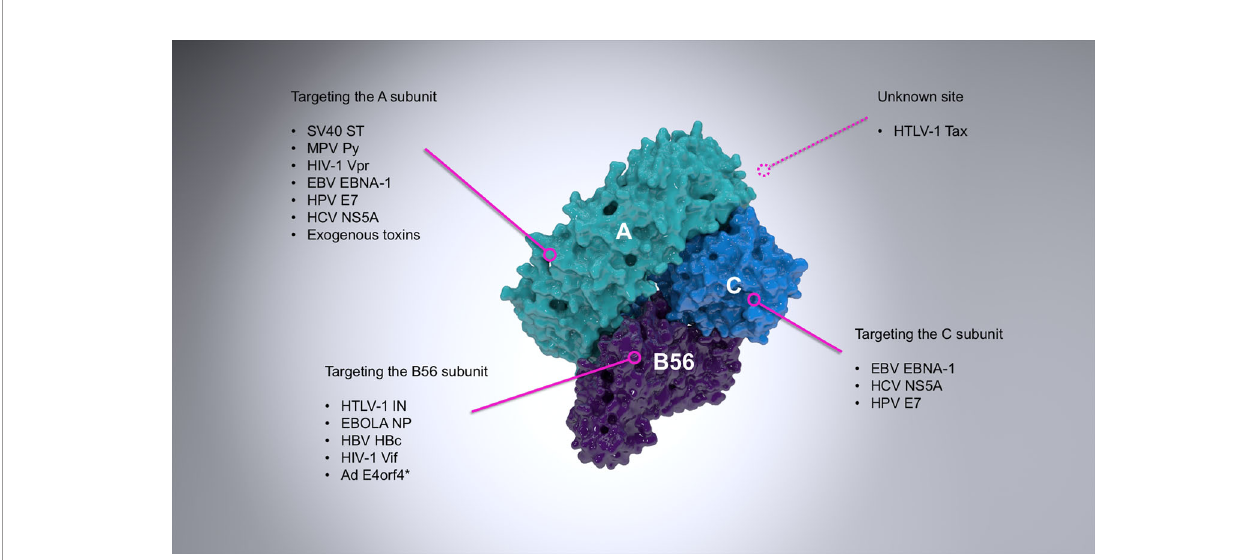
FIGURE 1 | A summary of the most important examples of PP2A targeting by viruses. PP2A is a heterotrimer composed of the scaffold (A; cyan), regulatory (B56; purple) and catalytic (C; light blue) subunits. The fi gure shows a B56-containing PP2A holoenzyme (PDB ID: 2IAE). Viral proteins interact with PP2A via different subunits, as indicated where it is known. The vast majority of viral proteins known to interact with the regulatory subunit of PP2A target exclusively B56, although the adenovirus E4orf4 (asterisked above) can also target B55 subunits (Kleinberger, 2020) and some other viral proteins are known to associate exclusively with other regulatory subunits (for example the polymerase of rinderpest virus (Sleeman and Baron,